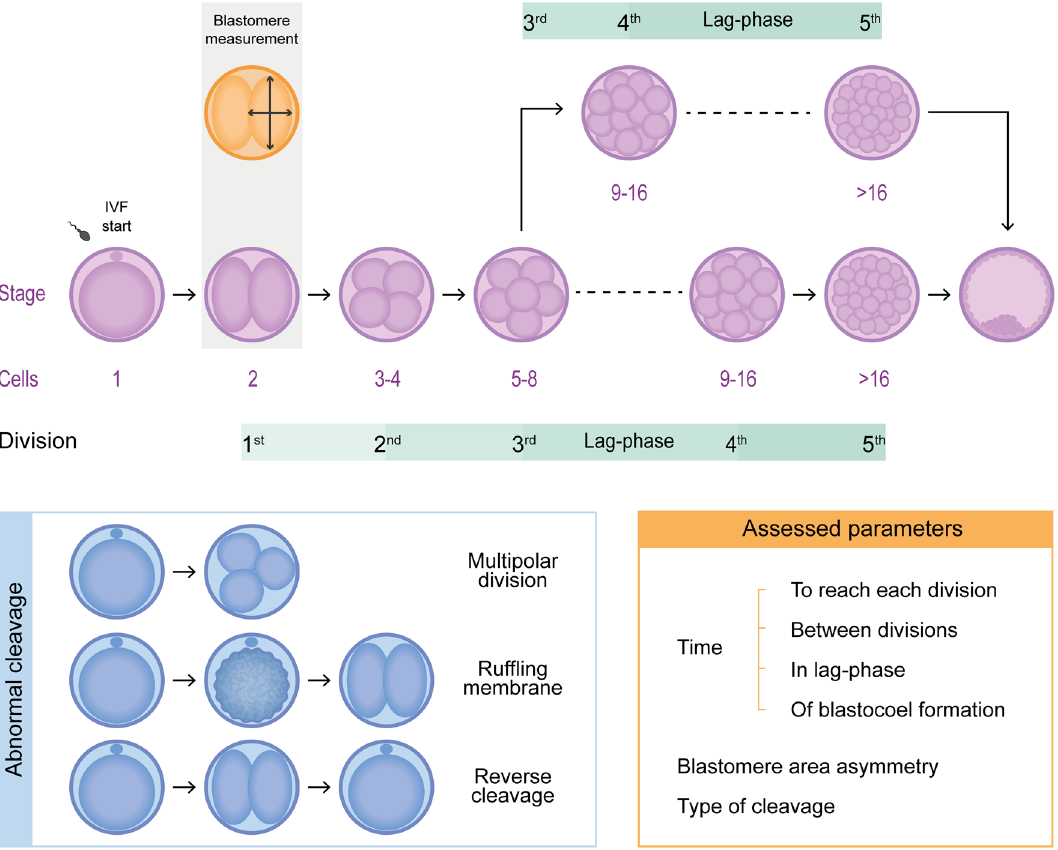
Figure 5. Schematic representation of embryo evaluation and parameters analyzed during time-lapse